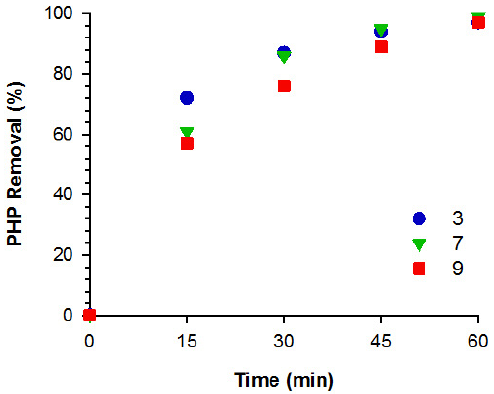
Fig. 7. Effect of pH on the PHP removal efficiency. Reaction conditions: 0.1 A, [catalyst] = 0.2 gL -1 , and [PHP]=10